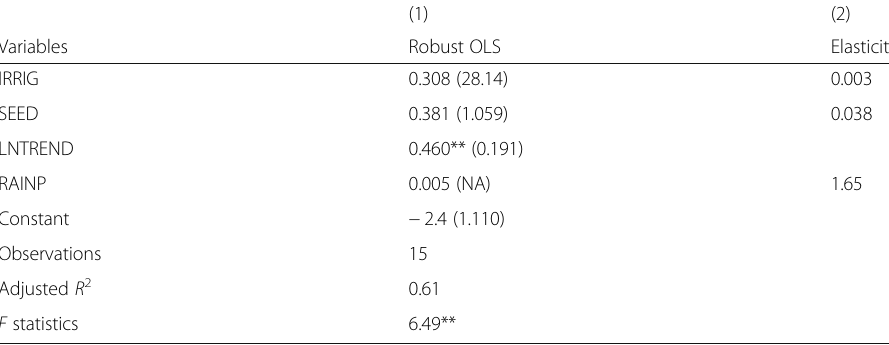
Table 5 Results for maize yield equation